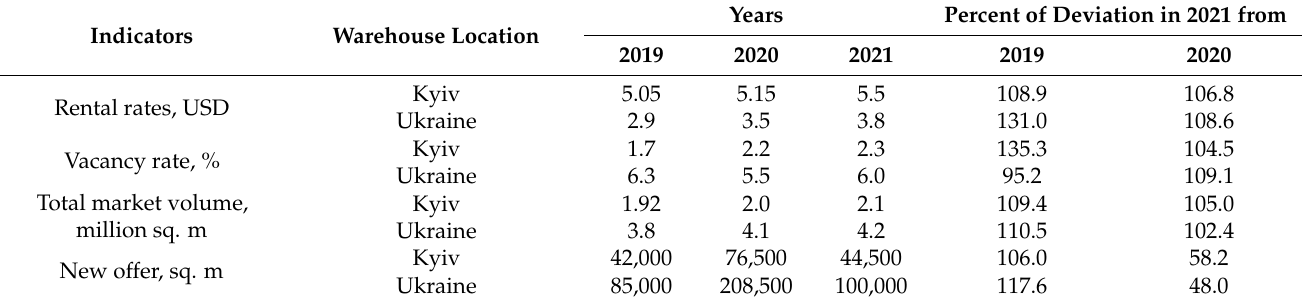
Table 3. Rental rates and vacancy of warehouse premises in Ukraine,